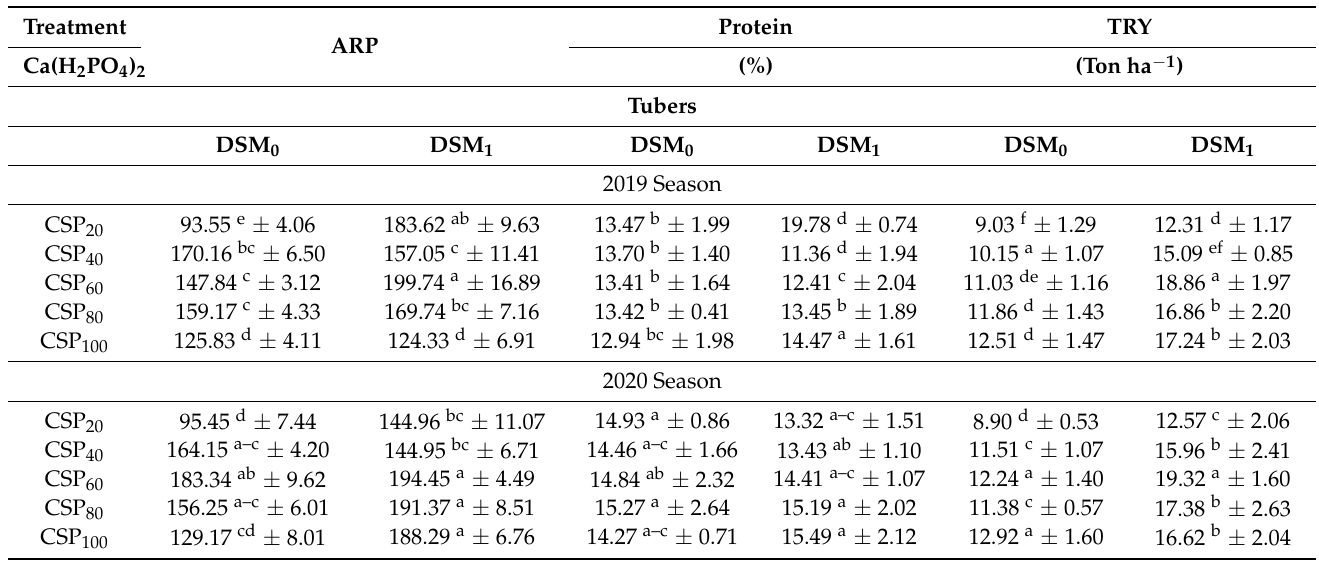
Table 7. Influence of interaction between phosphorus fertilizer and Bacillus megaterium DSM 2894 var. on some root micronutrients content of sweet potato plants grown on calcareous saline soil in 2019 and 2020 seasons.